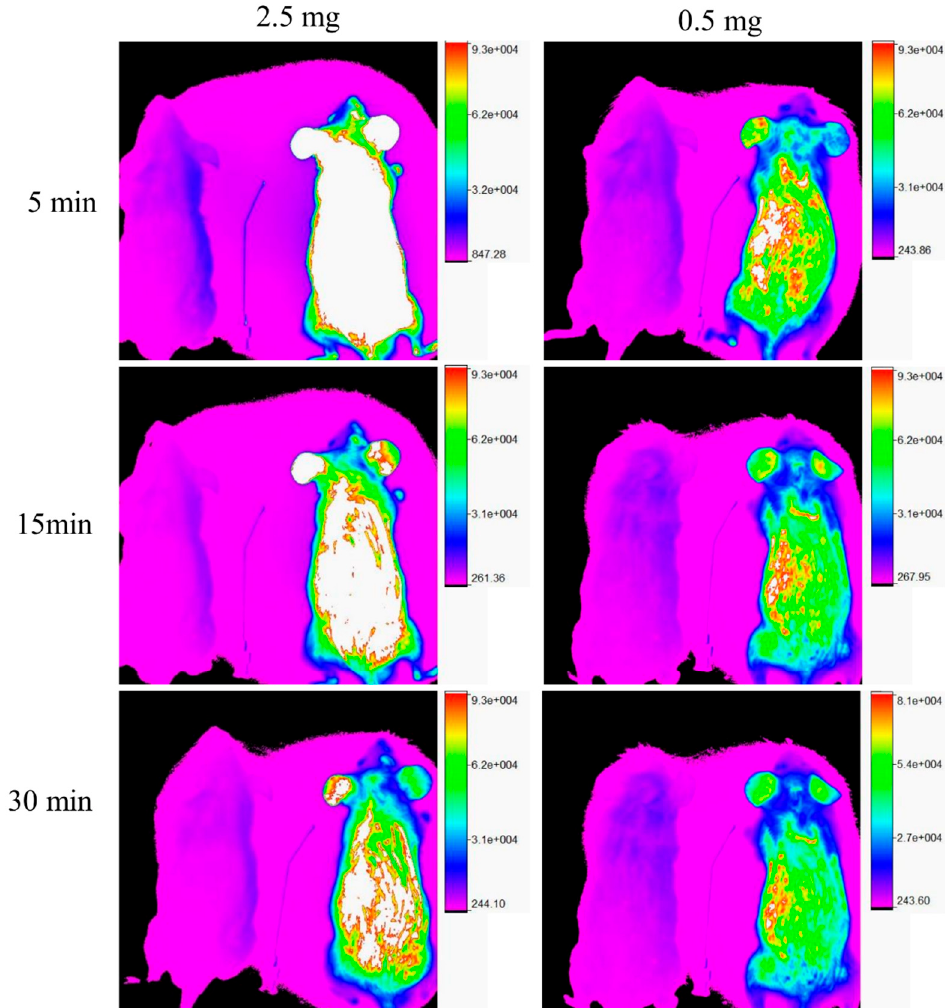
Figure 3. Representative in vivo fluorescence images of FITC-HPBCD treated mice. FITC-HPBCD (0.5 and 2.5 mg) was injected i.v. and images were recorded at 5, 15 and 30 min after injection. Untreated mice can be seen on the left and FITC-HPBCD treated mice can be seen on the right in each image. FITC-HPBCD distributed over the entire body of mice and the in vivo fluorescence decreased as a function of time.